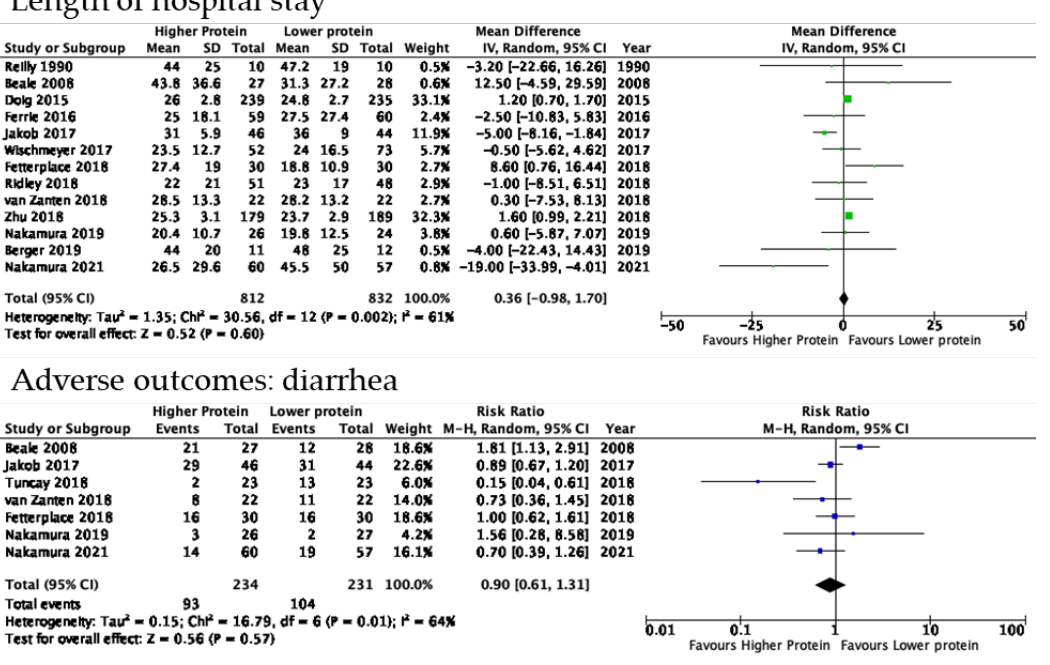
Figure 3. Forest plot of studies included in the optimal protein delivery analysis. Included studies were [52,53,55] in ADL, [27,49] in physical function, [45,53,55] in muscle mass change, [27,53,54,56] in QOL score, [27,44 – 46,48,49,52 – 56] in mortality, [27,44 – 49,51 – 56] in length of hospital stay, [44,47 – 50,53,55] in adverse outcomes.